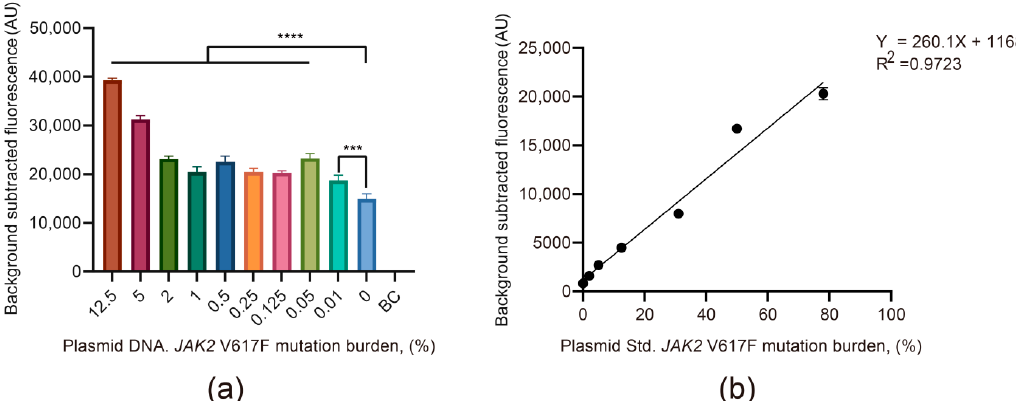
Figure 2. The viability and sensitivity evaluation of the JAK2 V617F/Cas12a fluorescence detection system using recombi- nant plasmid. ( a ) Fluorescence signals of mixed plasmid DNA with different mutation ratios. The concentration of plasmid DNA in each sample was 0.01 pg/ μ L. BC, blank control. Data represent means ± SD, with n = 3 replicates (**** p < 0.0001, *** p < 0.001). ( b ) The linear relationship between the mutation ratio of mixed plasmid DNA and the fluorescence signal. The concentration of plasmid DNA in each sample was 0.01 pg/ μ L. The mutation ratio range in which the calibration cure was linear was 0–78% ( R 2 = 0.9723). 0%, wild-type plasmid DNA.